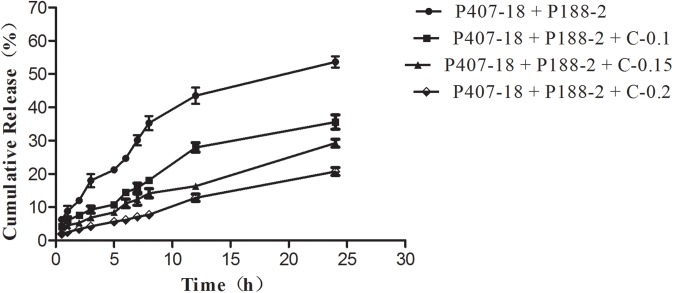
Release profiles of APS for the first 24h from in situ forming gel formulations containing CMC-Na with different concentrations in PBS at 37°C (n = 3; error bars were omitted for clarity).